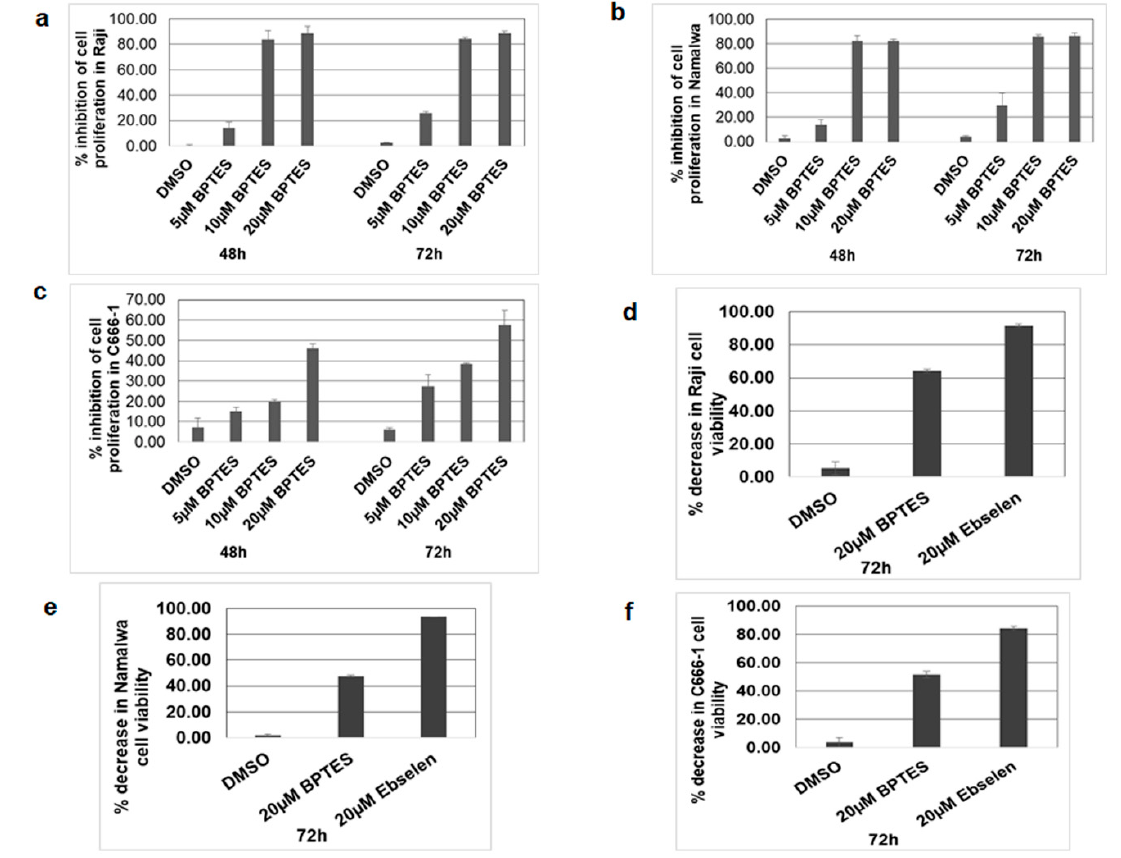
Figure 8. KGA, GAC, and GLUD1 inhibitor blocked cell proliferation in EBV-infected cells. ( a ), ( b ), and ( c ) Raji, Namalwa, and C666-1 were treated with control DMSO or 5, 10, and 20 µM BPTES. After 48-h and 72-h treatments, the cells were pulsed with BrdU for 2 h and the incorporation of BrdU was measured by the BrdU cell proliferation assay kit. Graphs represent the percentage inhibition of cell proliferation in Raji ( a ), Namalwa ( b ), and C666-1 ( c ). ( d ), ( e ) , and ( f ) Raji, Namalwa, and C666-1 were treated with 20 µM BPTES and 20 µM ebselen for 72 h, after which the cell viability was monitored by MTT assay and expressed as percentage decrease in viability in Raji ( d ), Namalwa ( e ), and C666-1 ( f ). Error bars represent the mean ± SD of two independent experiments.